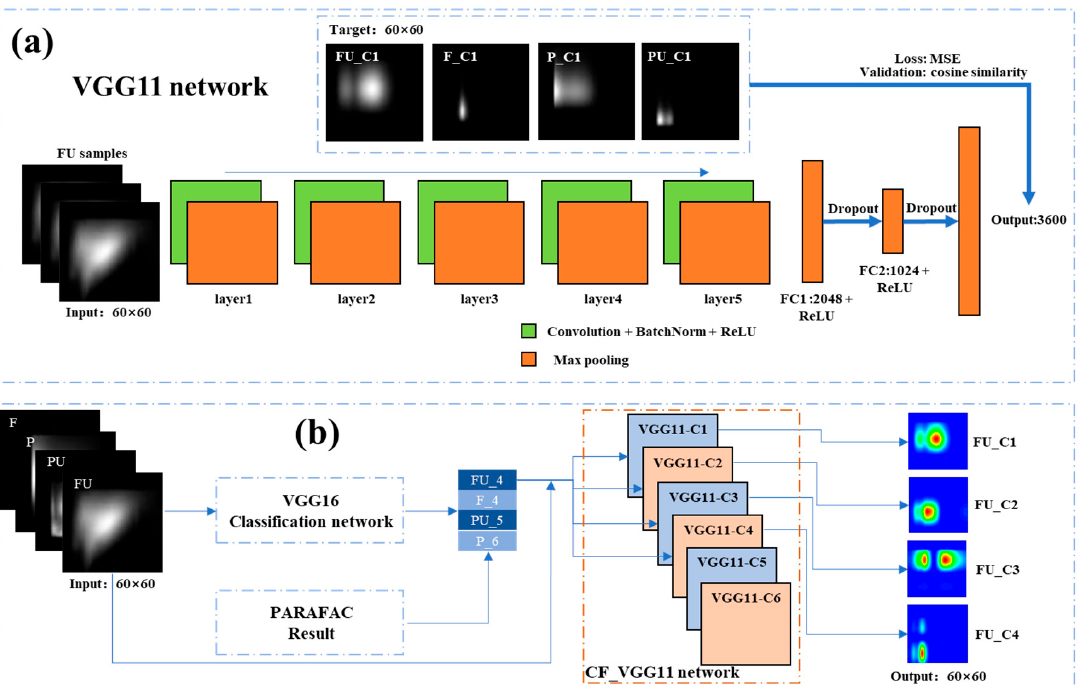
Figure 6. ( a ) is the single-layer network structure of VGG11; ( b ) is the structure of the whole fitting network. In ( a ), the input is a grayscale image of size 60 × 60 and the output is a vector of size 3600. The output vector can be reshaped as a matrix of size 60 × 60. VGG11 network contains 5 convolution-batch norm-pooling layers and 3 fully connected layers. The first and second fully connected layers are followed by a dropout layer, which can prevent the network from overfitting. VGG11 network is trained by the MSE loss function, and the training effect is verified by the cosine similarity. FU_C1 in this figure represents 1st component map of FU, as the other 3 component maps. Each layer represents a group of “convolution-batch norm-relu-Max pooling”. Input is the grayscale image of the network (taking the FU sample as an example), and the target is the label fitted by the convolution network. In ( b ), four types of 3D-EEMs samples are first classified by the VGG16 classification network. After obtaining the classification results, combined with the component map number from PARAFAC analysis, the classification results and original 3D-EEMs are input into the CF-VGG11 network, and the component maps of 3D-EEMs can be obtained through CF-VGG11 network fitting. Among them, FU_4 indicates that the FU samples contain 4 component maps. VGG11-C1 represents the convolution network used to fit the first component. By inputting each type of 3D-EEMs to VGG11-C1, the first component map of each type of data can be obtained, which is similar to the other 5 subnetworks of